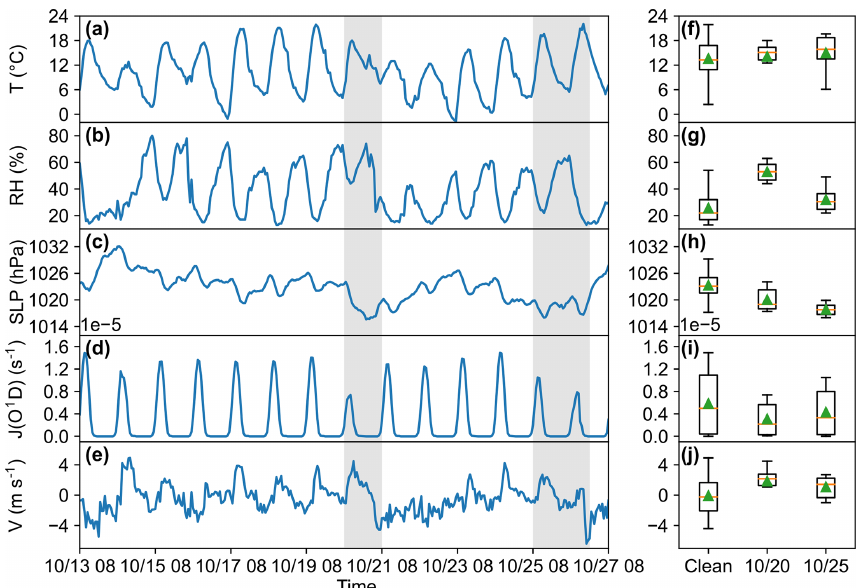
Figure 4. (a–e) Time series of observed temperature ( T ; degrees Celsius), relative humidity (RH; percent), sea level pressure (SLP; hec- topascals), photolysis rate for O 3 ( J ; per second), and meridional wind ( V ; meters per second) during 13–27 October at the SDZ site. O ( 1 D ) The shades denote the polluted days. (f–j) Box plots for daytime meteorological parameters during clean days (13–19 and 21–24 October) and 2 polluted days. The red lines and green triangles denote the median and mean values,